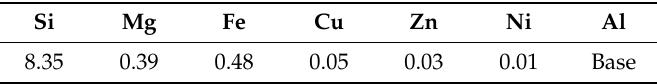
Table 1. Aluminum 356 alloy chemical composition (wt %).